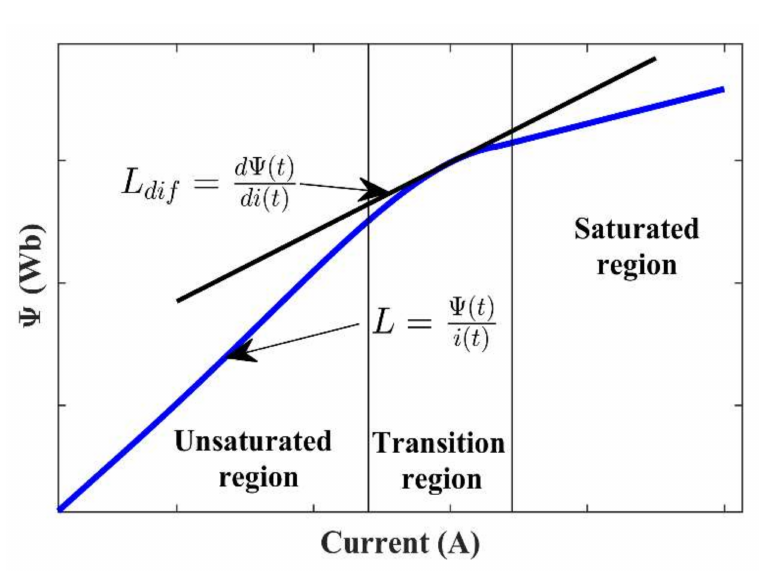
Figure 1. Example of a magnetization curve for a ferrite